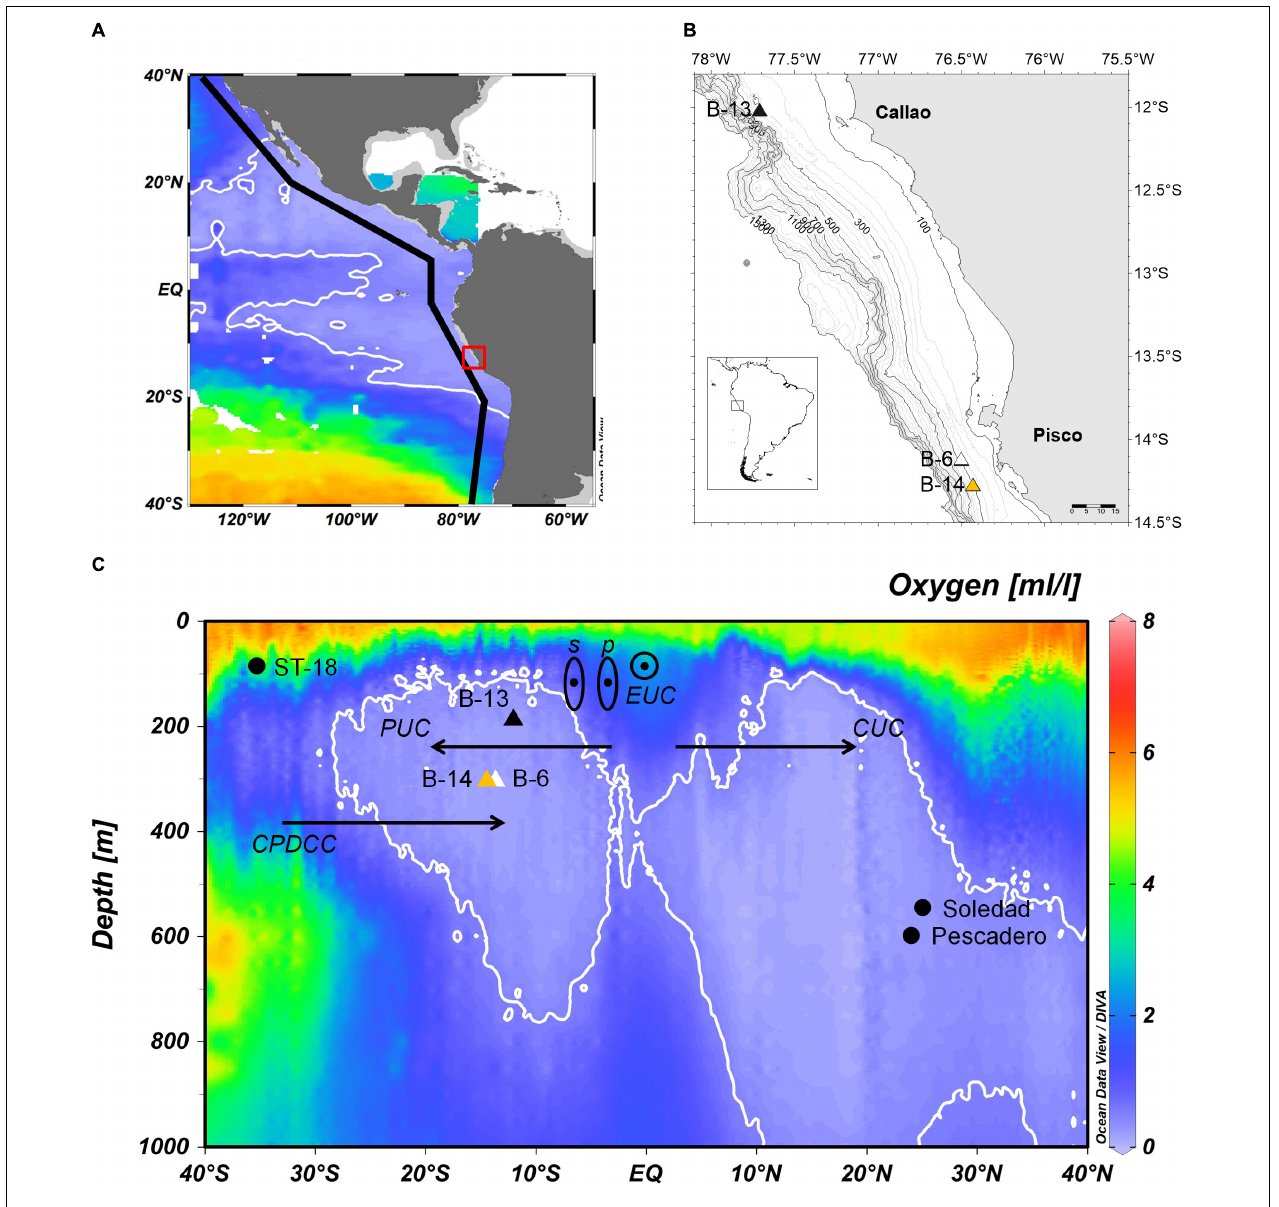
FIGURE 1 | Site location and description of box cores used in this study. (A) Mean dissolved oxygen concentration (ml l − 1 ) at 400 m depth at the Tropical East Pacific (data available in World Ocean Database 2013). (B) Map of central Peru indicating the location of B0405-13 (B-13; 12 ◦ 00’ S, 77 ◦ 42 (cid:48) W, 184 m), B0405-06 (B-6; 14 ◦ 07 (cid:48) S, 76 ◦ 30 (cid:48) W, 299 m) and B0506-14 (B-14; 14 ◦ 27 (cid:48) S, 76 ◦ 43 (cid:48) W, 301 m). (C) Dissolved oxygen concentration in an oceanographic section along the coast of America (black line in inset in A), showing the position of the cores in relation to the OMZ and the principal subsurface currents. Triangles are our box cores (B-13, B-6 and B-14) and black circles are other sites considered in the discussion: Soledad and Pescadero (Deutsch et al., 2014) and ST-18 (Srain et al.,